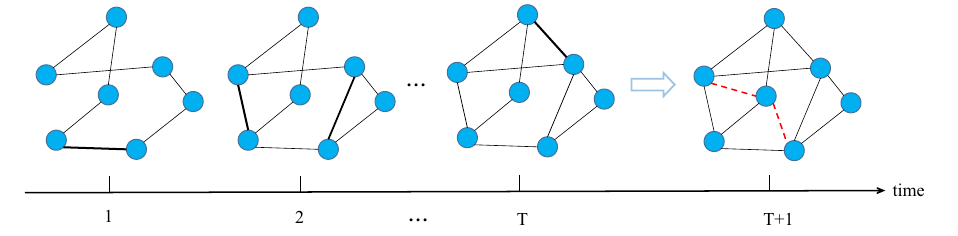
Figure 1. Schematic diagram of temporal link prediction.